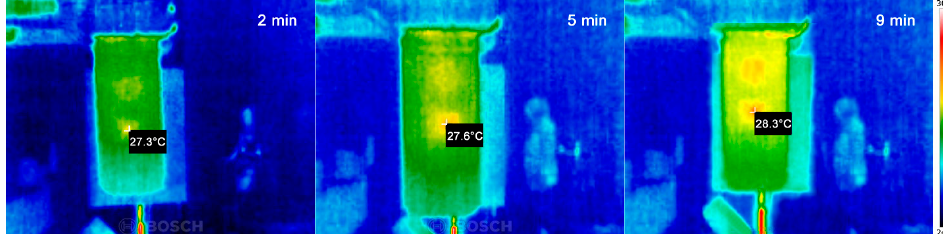
Figure 16. Images from thermo camera showing heating of AgNP colloid solution during irradiation process after 2, 6, and 9